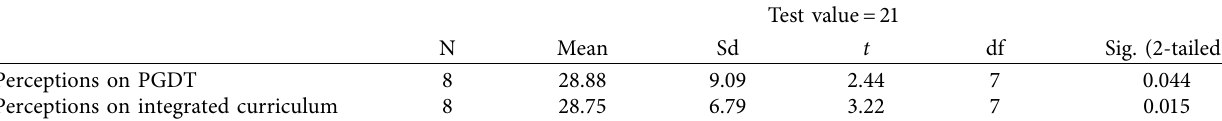
Table 4: One-sample t- test result of teachers’